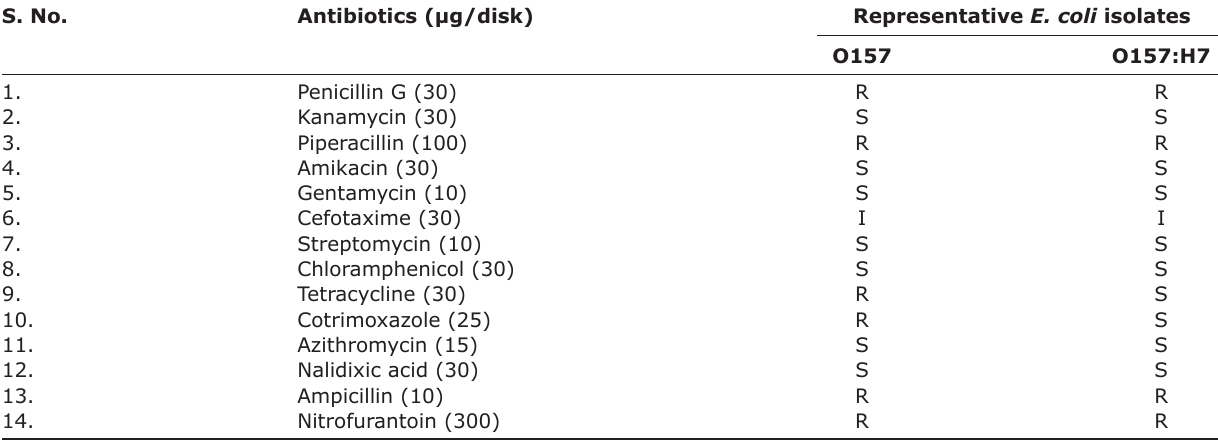
Table-4: Antibiotic susceptibility of E. coli O157 and O157:H7 isolates. S. No.